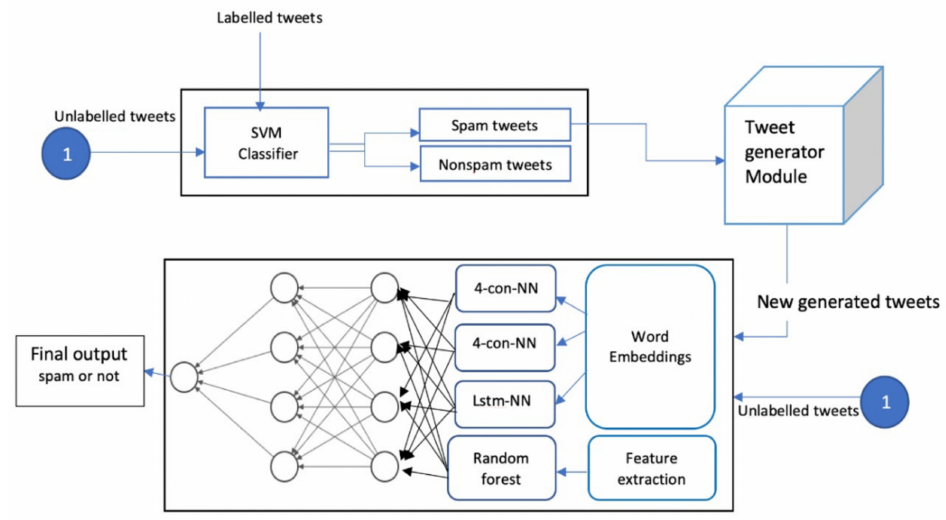
Figure 2. The proposed framework.